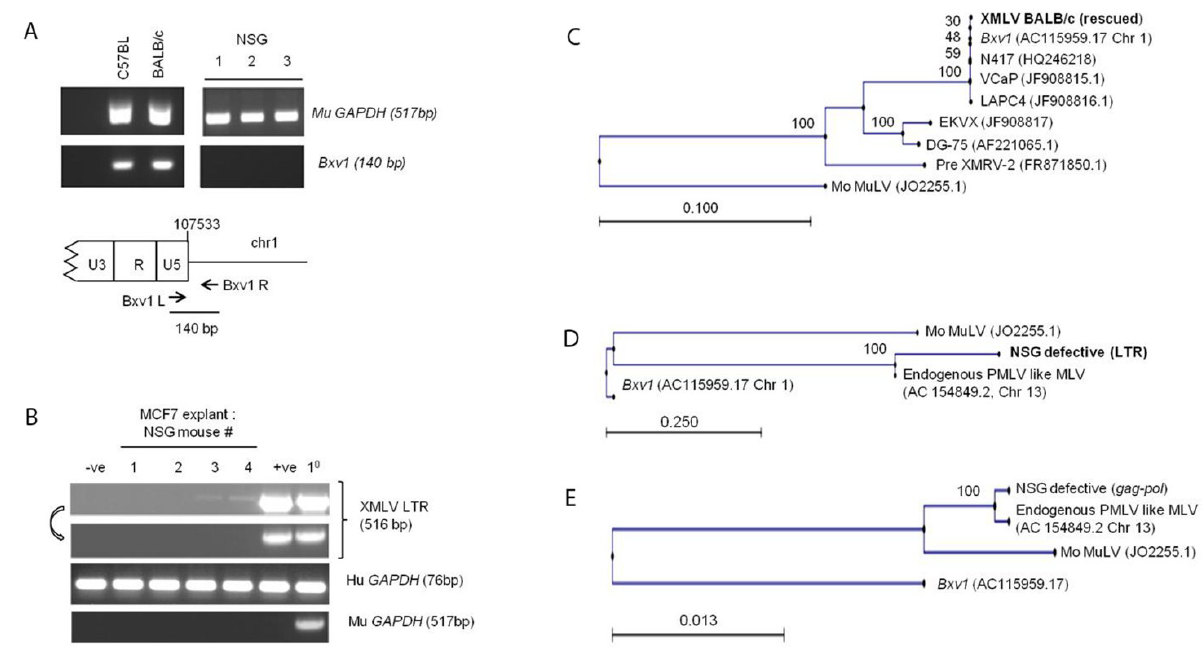
Figure 2. Analysis of endogenous MLVs in NSG mice and recovered viral sequences from xenografts. ( A ) DNA PCR analysis of the Bxv1 locus in BALB/c, C57BL/6 and NSG mice. Although the breeding history of NSG mice includes the C57/BL6 strain, NSG mice do not contain an XMLV provirus at the Bxv1 locus. Murine GAPDH gene primers provide the loading control and _ denotes no added DNA control; ( B ) Two out of four MCF7 xenograft explants from NSG mice were DNA PCR positive for MLV primers after one passage of filtered supernatant on fresh MCF7 cells, but this signal was lost after a further round of passage (denoted by arrow). 1° denotes a primary explant which contained significant residual murine cellular DNA sequences. The positive control (+ve) was MCF7 cells infected with passaged XMLV. The negative control (−ve) was uninfected MCF7 cells; ( C – E ) Sequences were aligned and phylogenetic trees were generated using the Neighbor Joining method. Scale bars denote genetic distance and bootstrapping values are indicated at the nodes. Bootstrapping values were based on 100 replicates. The tree in c is based on a ~7.5 kb fragment of the newly recovered XMLV from MCF7 xenografts in BALB/c mice. This sequence was virtually identical to Bxv1 and several independent xenograft-derived isolates. Trees d and e show alignment of LTR and gag-pol fragments from the defective virus in MCF7 explants derived from NSG mice as shown in panel b. These sequences align most closely with an endogenous polytropic MLV-like provirus on mouse chromosome 13 (see